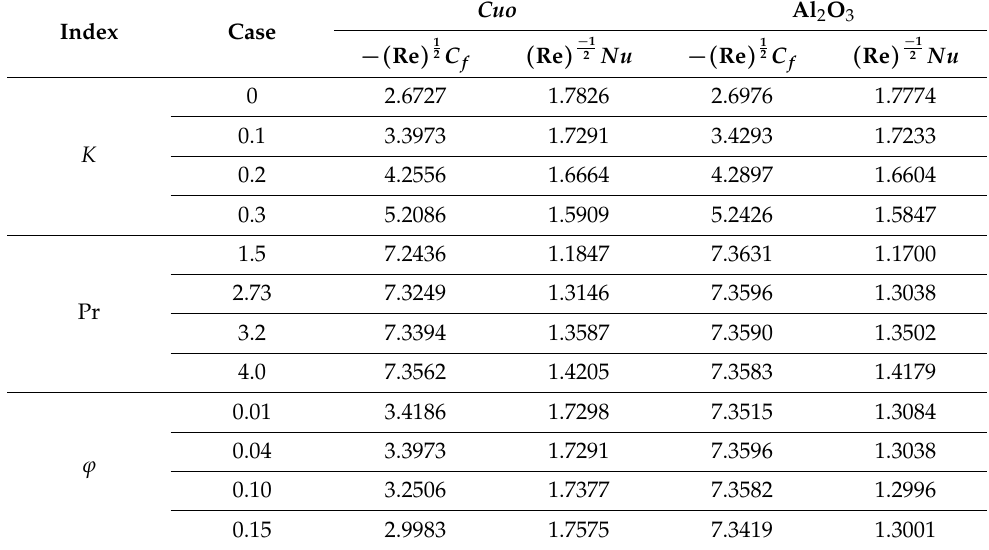
Table 4. Behavior of skin friction and Nusselt number when φ = 0.04, Pr = 2.73 and K = 0.1.